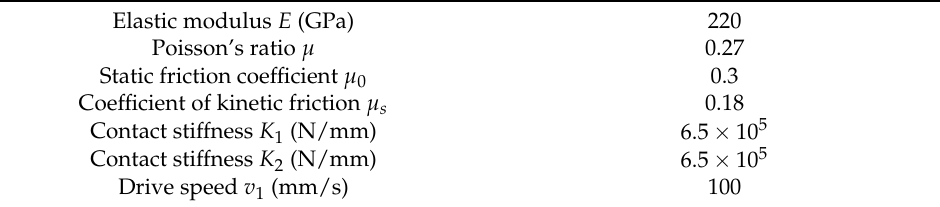
Table 2. ADAMS simulation parameters of the trigger